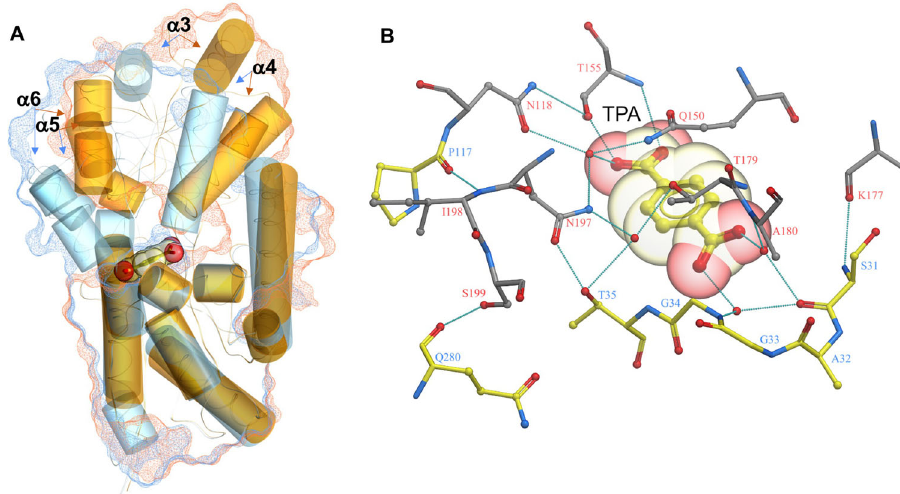
Fig. 6 Structure of TphC showing ligand-induced changes. A TphC crystal structure in both an apo (open — orange) and TPA-bound (closed — blue) conformation have been superimposed (SSM superposition of domain 1) in ICM-Pro. The protein surfaces for each of the two states are shown as meshes and coloured according to their respective structure (open — orange, closed — blue, the surface representations correspond to thin slices through the surface centred on the TPA-binding site). Helical elements within the structure have been highlighted as large cylinders to clearly show the reorientation between domains 1 and 2 which occur upon TPA binding. TPA is shown in both ball and stick and semitransparent CPK spheres (all atom colours). B A ball and stick representation of the TPA-binding site along with highlighted hydrogen bonds that form both between the protein and the TPA and also between the protein domains upon TPA binding. Residues arising from domain 1 are shown with yellow carbon atoms while those from domain 2 are shown with grey carbon